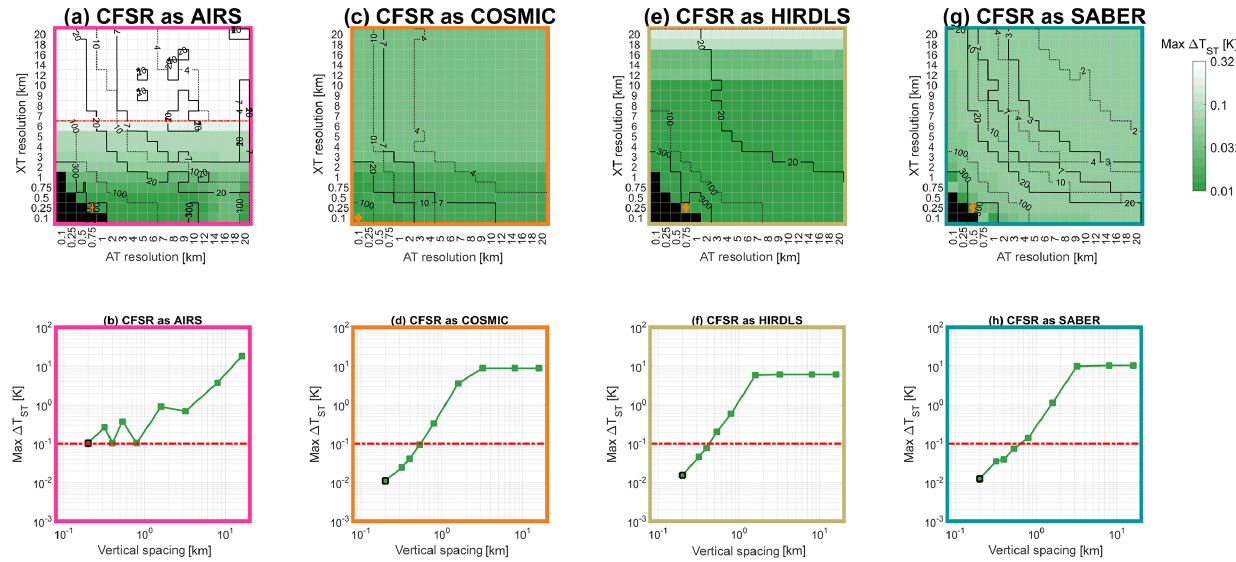
Figure B1. Sensitivity testing results. The top row shows the results of horizontal sensitivity tests, plotted as the maximum difference in temperature between the test and a baseline indicated by the orange diamond; line contours show the required runtime. The lower panels show the results of vertical sensitivity tests, plotted as the maximum difference from a reference level of 1 / 160 decades of vertical spacing.